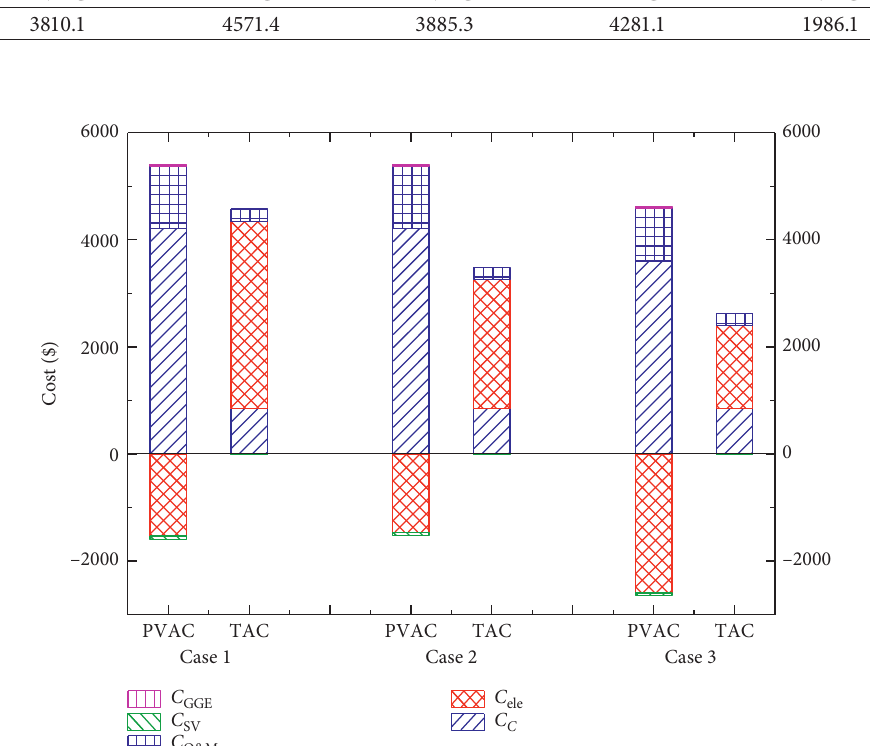
Figure 4: LCC analysis of three